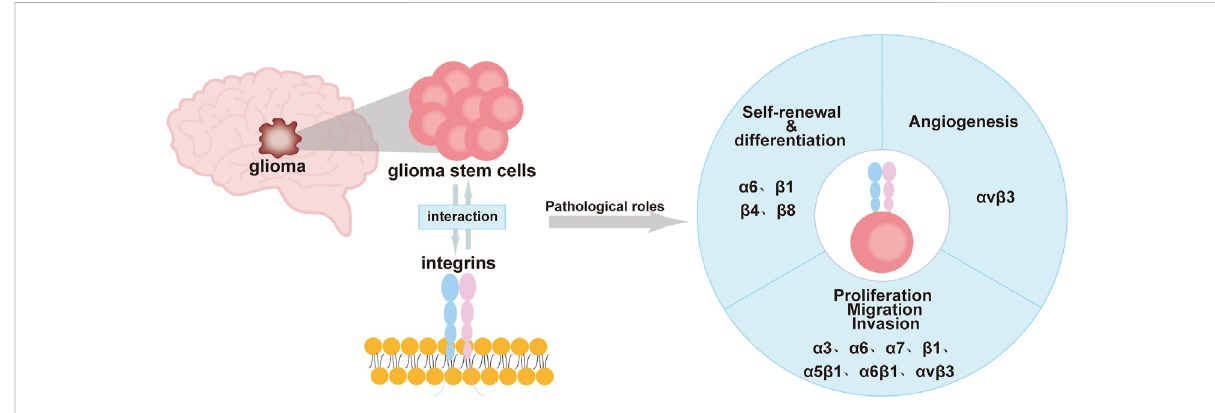
FIGURE 1 Roles of integrins in GSCs including self-renewal, differentiation, immune regulation, proliferation, migration, invasion, and angiogenesis.